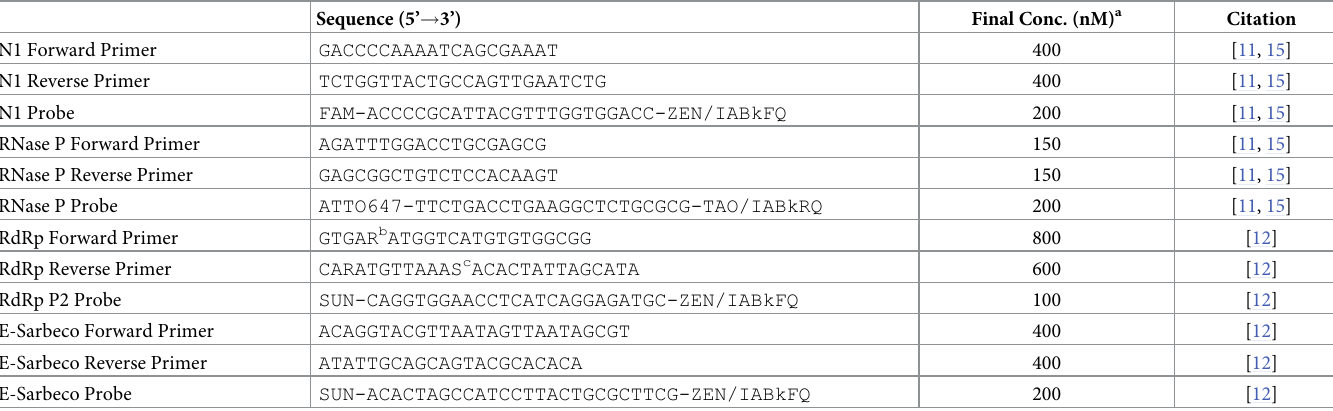
Table 1. Primer and probes tested for the development of the LuNER